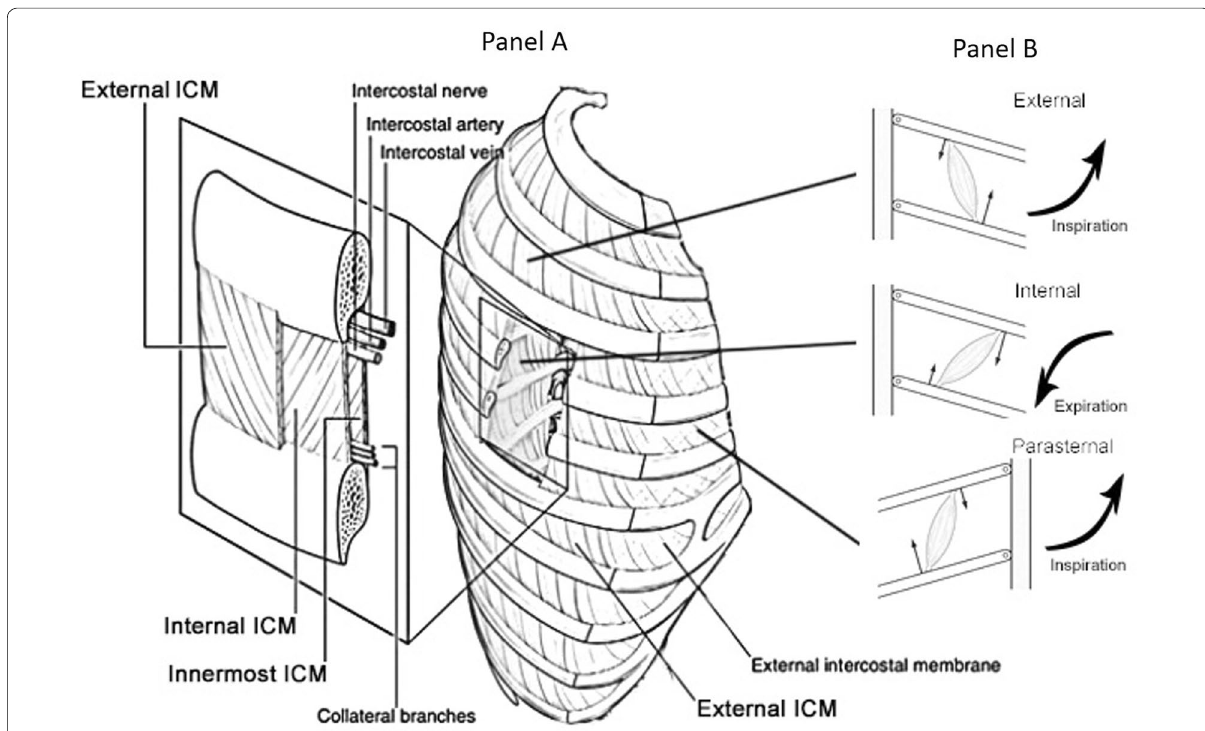
Fig. 1 Intercostal muscles anatomy. A schematic picture of anatomy and function of internal and external intercostal muscles. Panel A : the figure represents the anatomical distribution of intercostal muscles. Panel B : the figure represents the schematic functional activity of intercostal muscles. In particular, the external intercostal connects the ribs in such a way that contraction of the muscles lift the ribs and the rib cage allowing to expand the anterior–posterior dimension of the chest wall. On the other hand, the contraction of the internal intercostal (oriented opposite to the external) determines the opposite effect such as lowering of the ribs and reducing the anterior–posterior